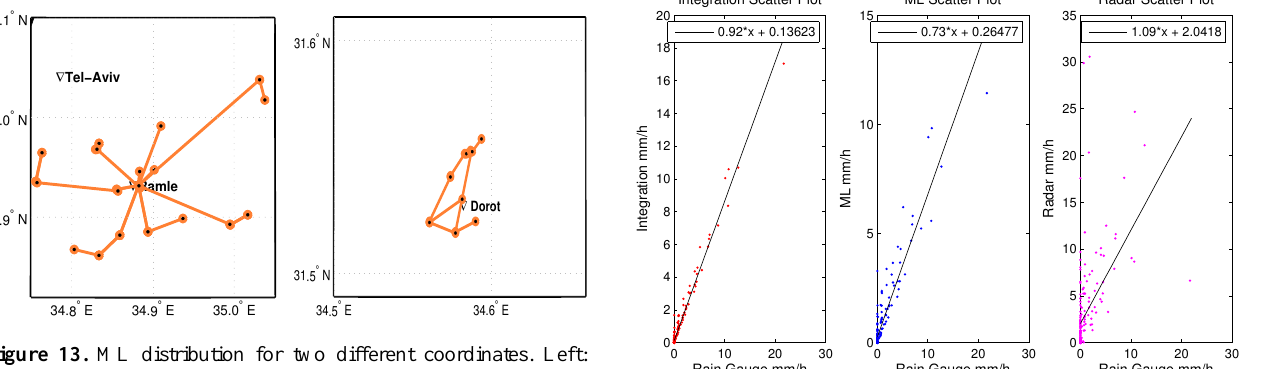
Fig. 16. Rain rates scatter plots of the Integration (left), the ML (middle) and the radar (right) with respect to theraingaugeinDorotsiteforevent(3).